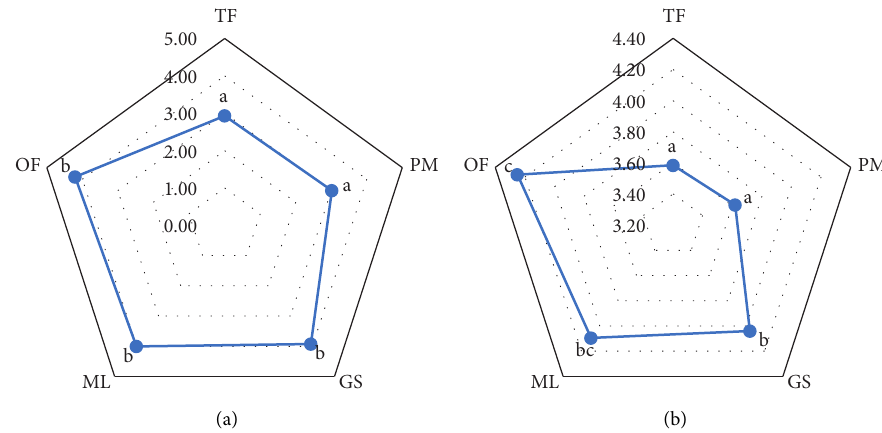
Figure 5: (a) Sensory evaluation of high-protein bars without chocolate covering; (b) with chocolate covering. Means in the same point with different superscripts ( a-c ) are significantly different ( P < 0.05, Tukey’s HSD test). OF oligofructose, TF—tapioca liquid fiber, ML—maltitol, PM—chickpea-maize liquid